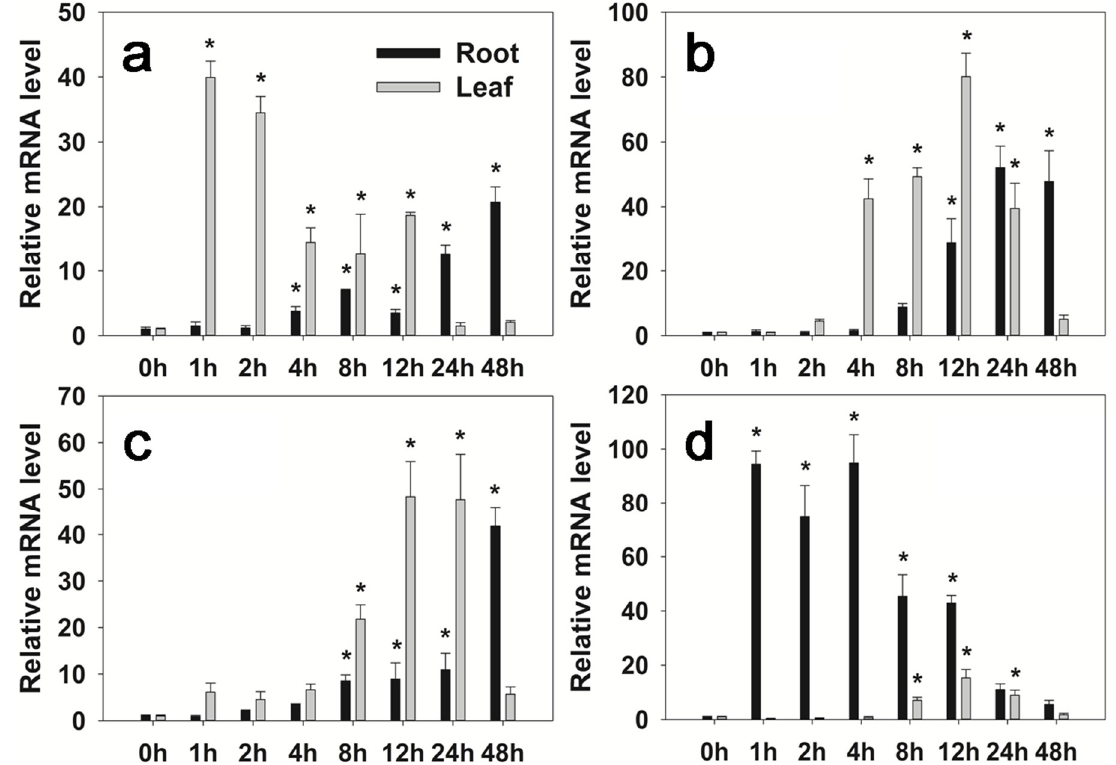
Figure 4. FaHsfC1b expression patterns in different abiotic stress conditions. Plants were treated under heat stress at 45 ◦ C ( a ), cold stress at 4 ◦ C ( b ), osmotic stress (20% PEG-6000), ( c ) or salt stress (150 mM NaCl) ( d ) during a 48 h period. qRT-PCR values were means ± SD of three biological repetitions (three technical repetitions for each biological repetition). Asterisks indicated significant differences of mean values at each time period of stress treatment regarding the value at 0 h (nontreated plants) for each tissue analyzed (root and leaf).